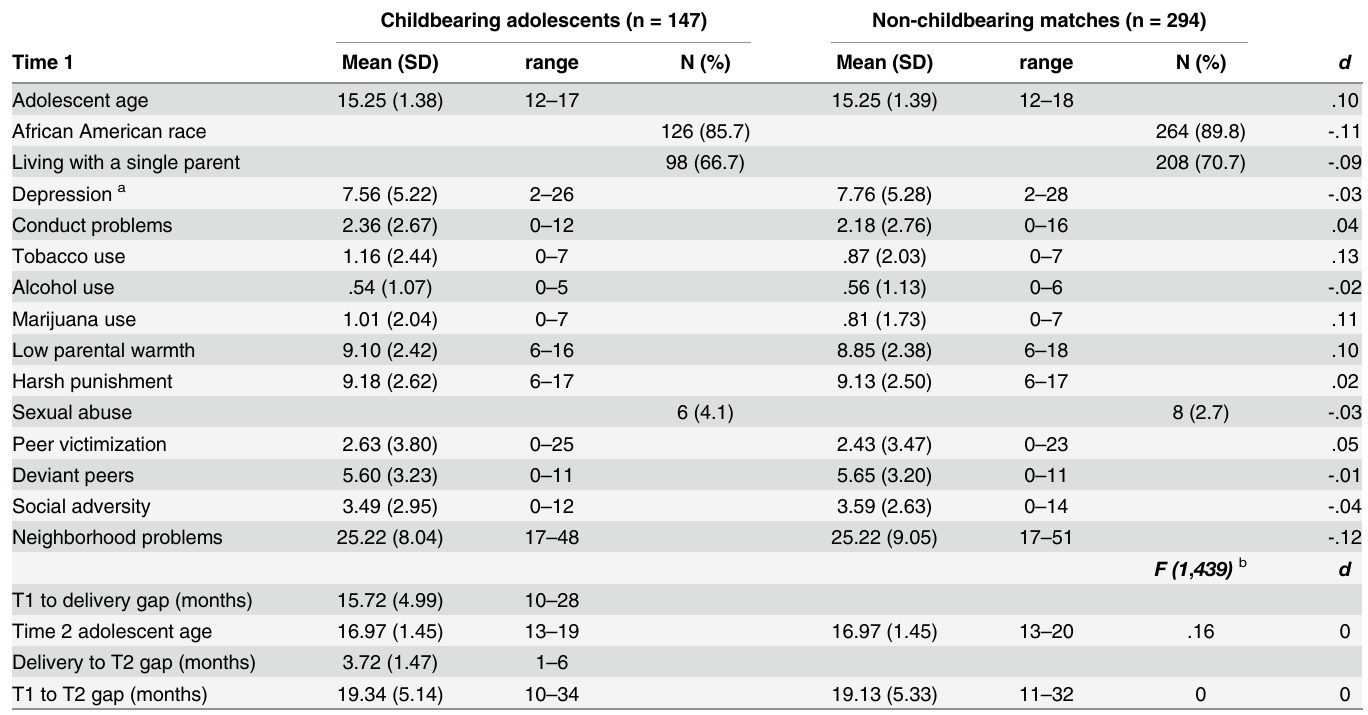
Table 1. Descriptive statistics of childbearing and matched non-childbearing